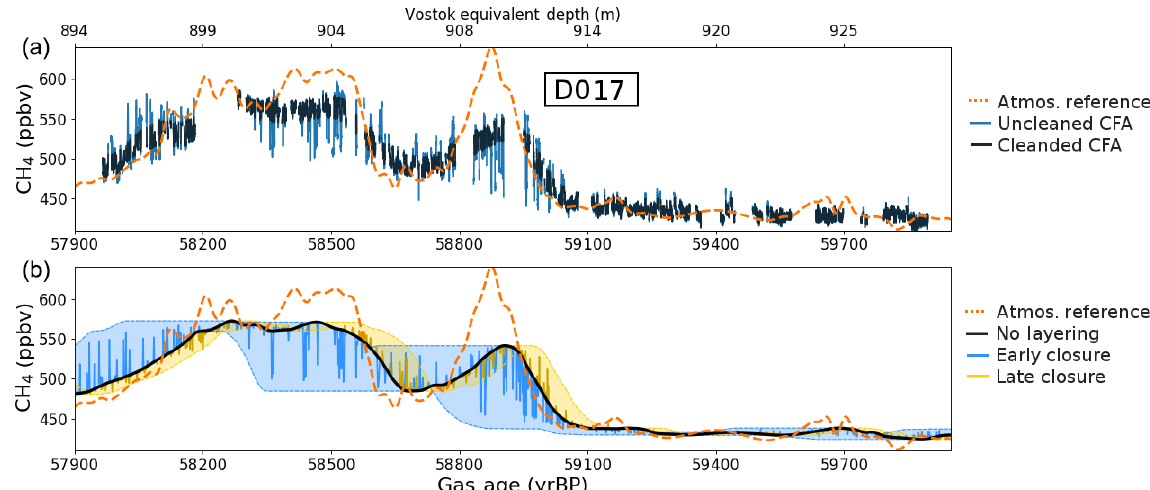
Figure 7. Same as Fig. 4 for the DO17 Vostok section. The methane data of the panel (a) are from Fourteau et al. (2017), and the atmospheric reference is from Rhodes et al.